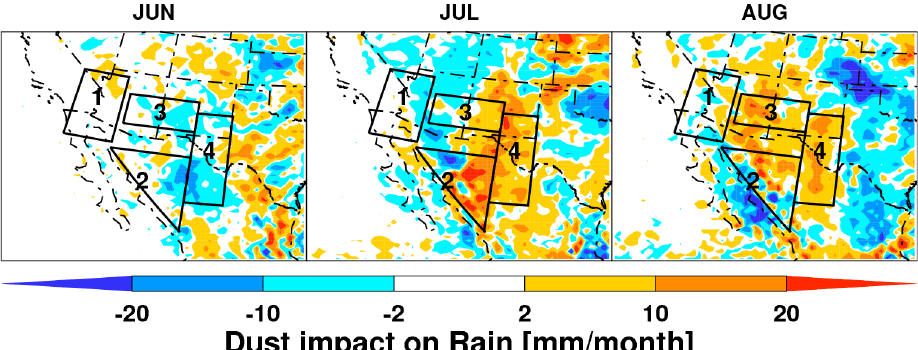
Fig. 9. Spatial distributions of monthly mean dust-induced change of precipitation from the WRF-Chem simulations in June, July, and August averaged for 1995–2009 over the NAM region. Four sub-regions are defined in the black boxes: Region 1 (DESERT), Region 2 (CORE), Region 3 (AZNM), and Region 4